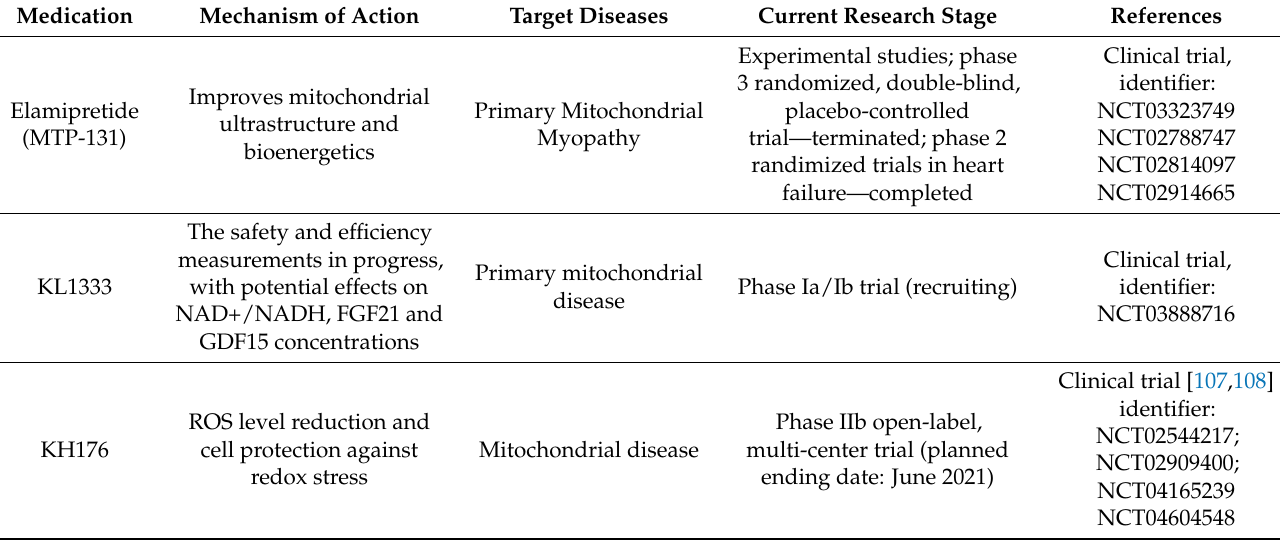
Table 1. Experimental medications targeting mitochondria. The efficacy of these medications in the treatment of AF was not tested. The clinical trial identifiers in the Clinicaltrial.org database are provided in the “References”